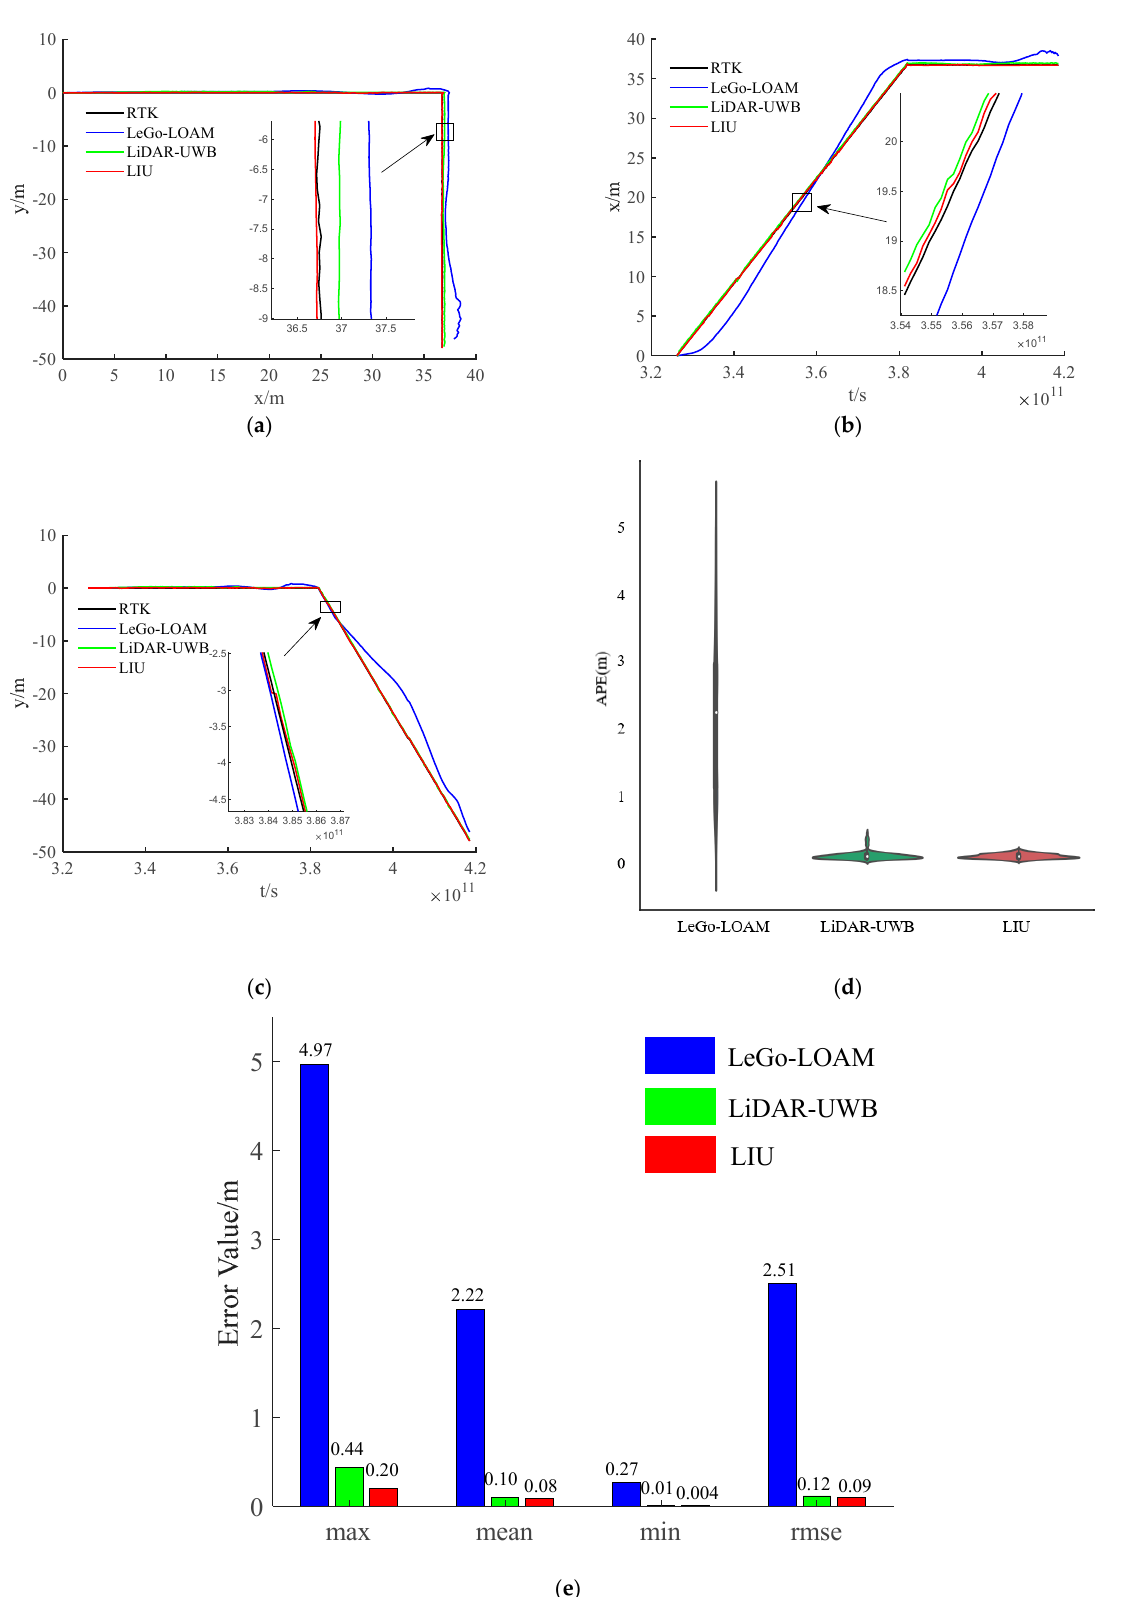
Figure 4. Experiment in a roadway with a length of about 85 m. ( a ) Trajectory curve; ( b ) position error along x-axis; ( c ) position error along y-axis; ( d ) APE violin histogram; ( e ) error value comparison.